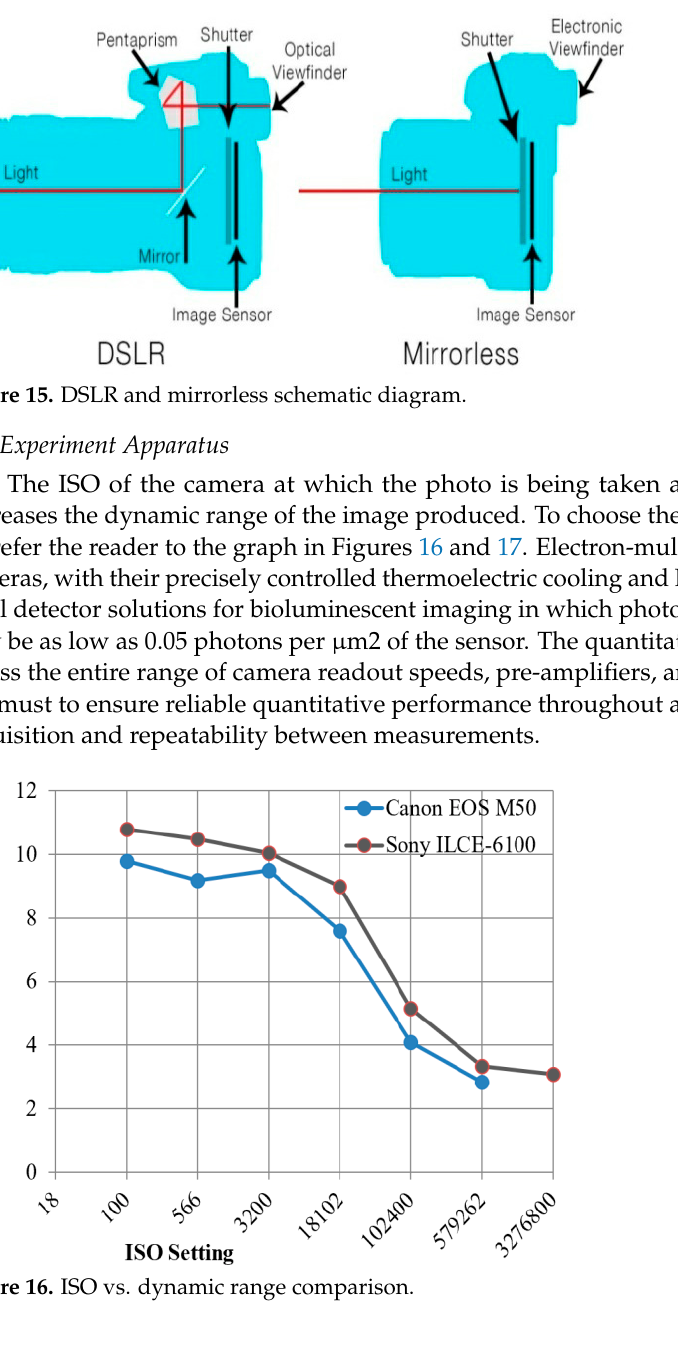
Figure 16. ISO vs. dynamic range comparison.